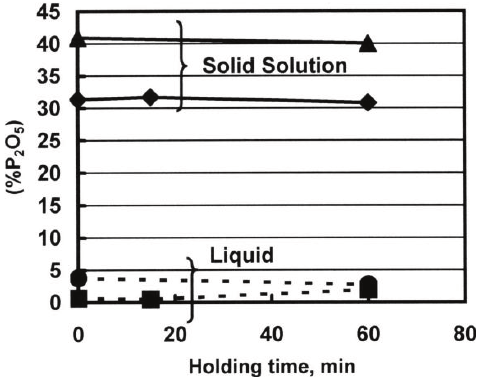
Figure 4. Change in P 2 O 5 content in solid solution and liquid phase with holding time.